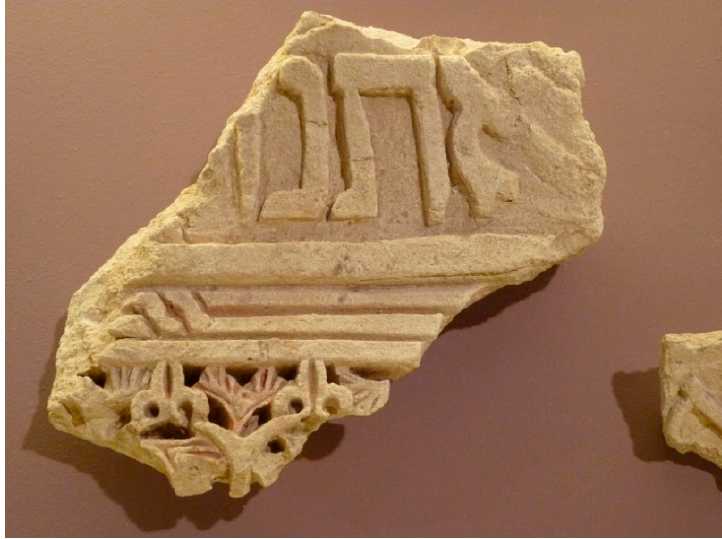
Figure 26. Fragment with Hebrew epigraphy, Molina de Aragón Synagogue. Author’s photo.